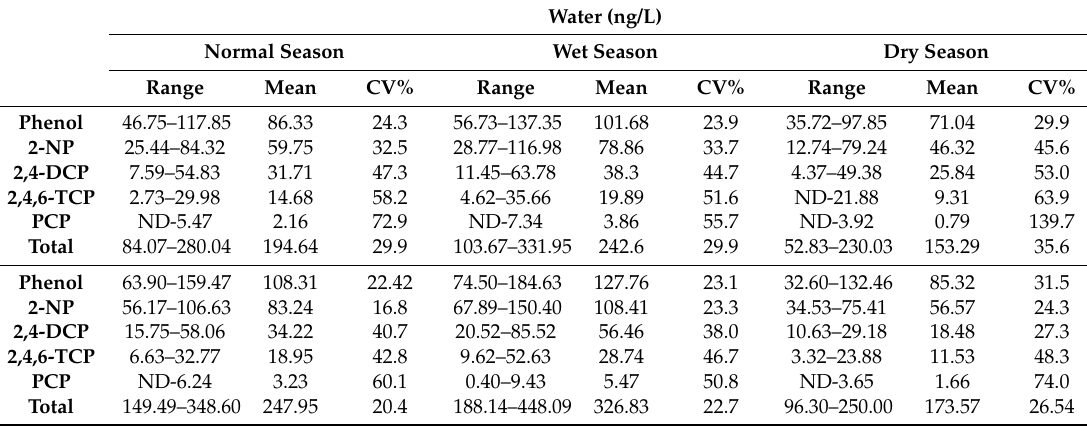
Table 1. Phenolic compound concentration ranges and mean values of 17 sampling sites for water and sediment across three water seasons in 2016. Normal Season: May; Wet Season: August; Dry Season: November.